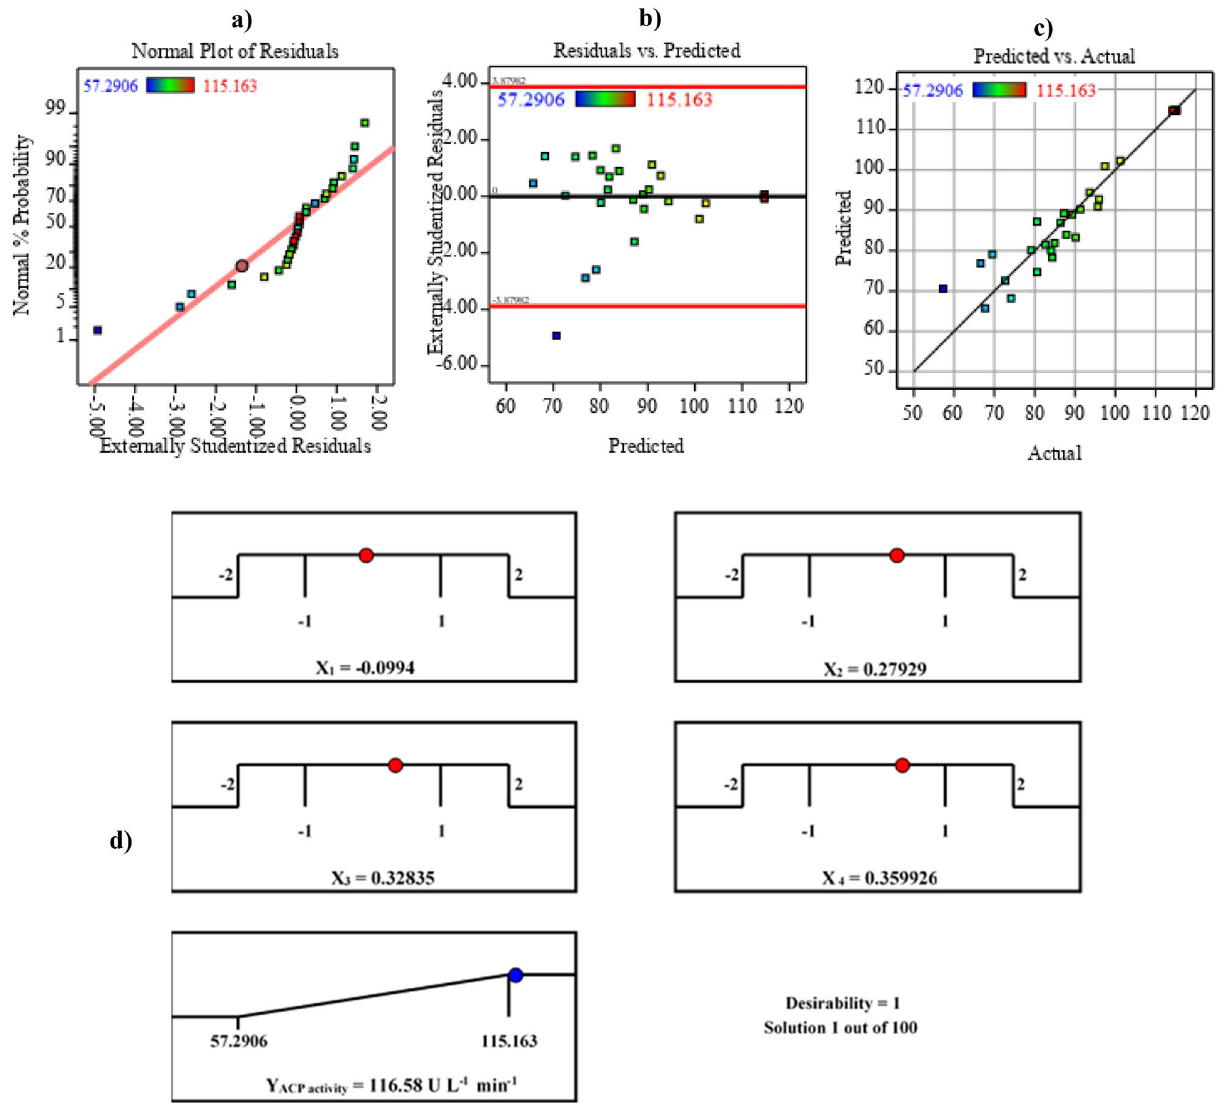
Figure 4. Model adequacy checking of Rotatable central composite design, (a) normal probability plot of the residuals, (b) externally studentized residuals versus predicted acid phosphatase production, (c) plot of predicted versus actual acid phosphatase production, and (d) the optimization plot displays the desirability function and the optimum predicted values for the maximum acid phosphatase